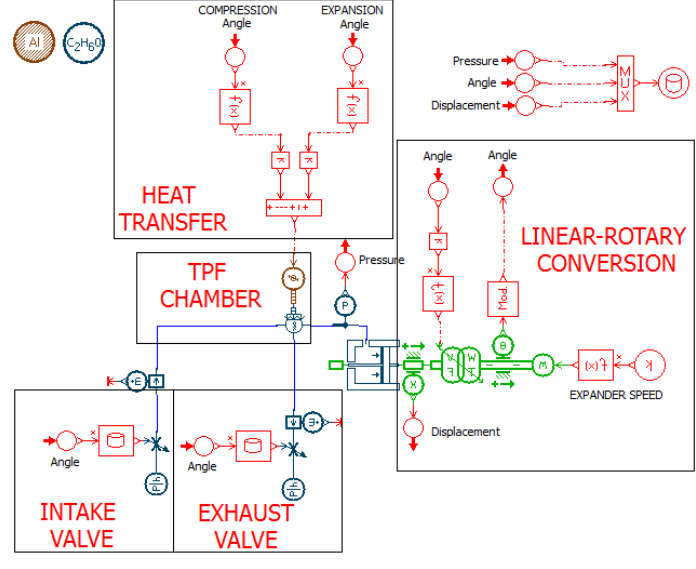
Figure 8. Zoom swash-plate piston expander model.